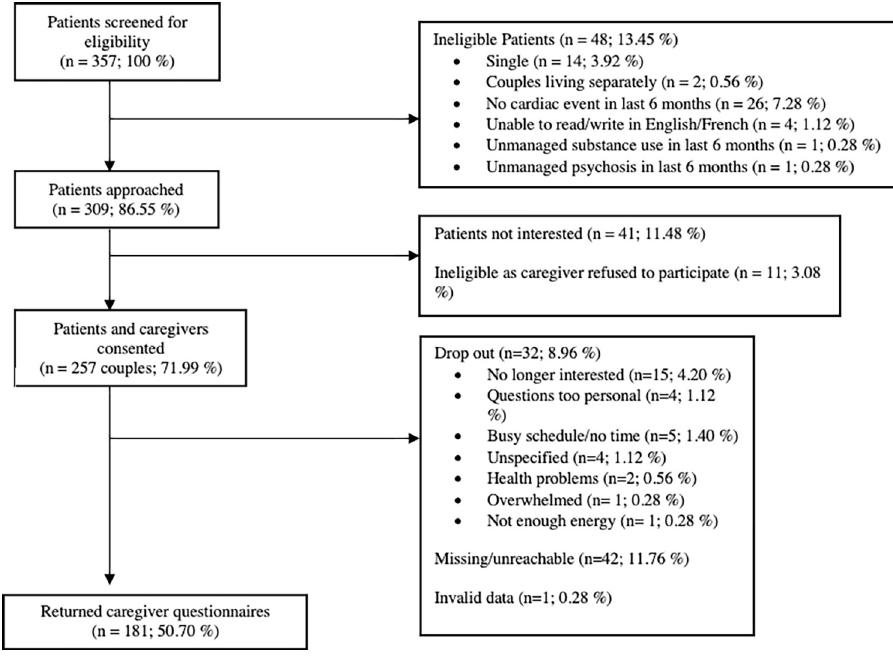
Fig 1. Participant